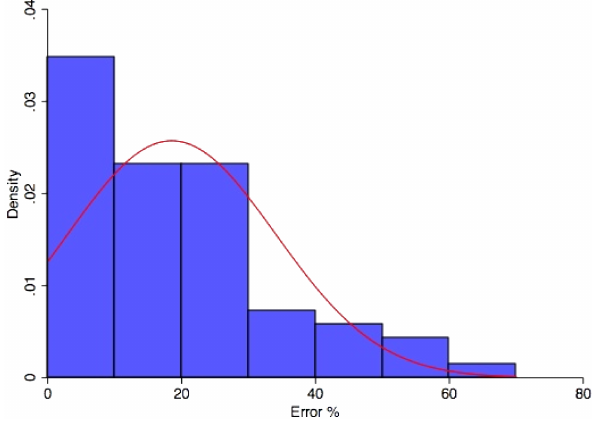
Figure 2. Probability density function of the reported mean absolute percentage error in rainfall estimates from remote sensing. A season or longer period is